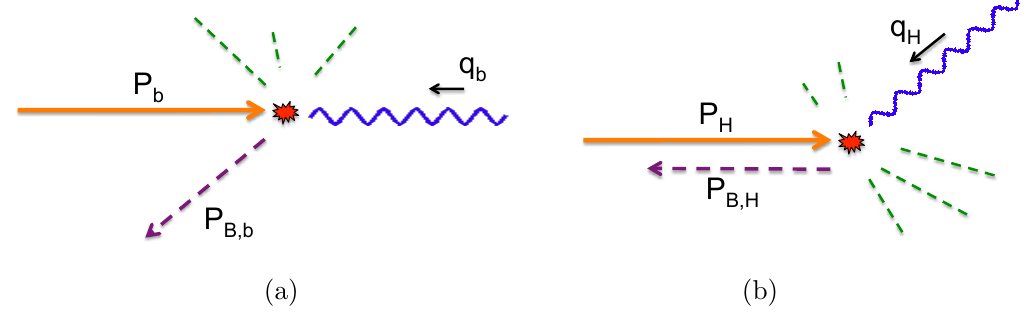
Figure 2 . The con(cid:12)guration of the proton, photon, and outgoing hadron in (a) the Breit photon frame and (b) the hadron frame. The dashed green lines again represent unobserved